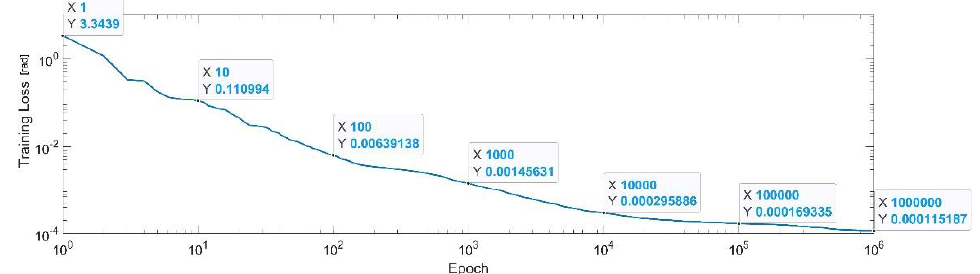
Figure 19. Convergence of the neural network for the first generalized coordinate 𝑞 4 (log scale).